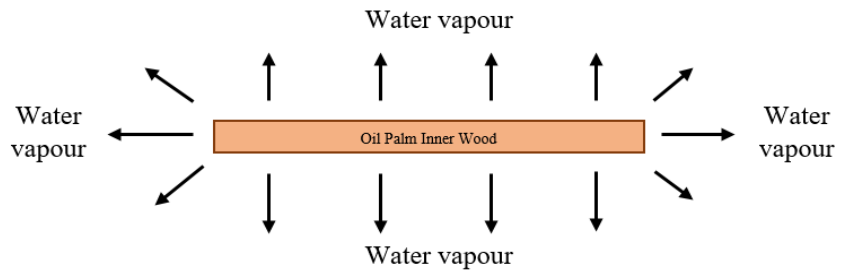
Figure 6. Water vapor is released from a sample of compreg oil palm inner wood during compres- sion.